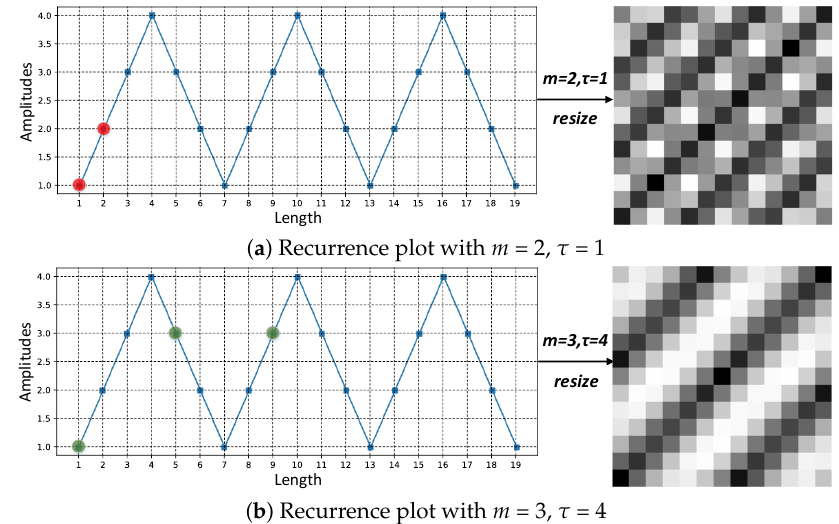
( b ) Recurrence plot with m = 3, τ = 4 Figure 4. The subsequences and RP images of a triangular periodic sequence, with different values of m and τ . The red and blue dots in ( a , b ) correspond to the first subsequences of the sequence when ( m , τ ) are ( 2,1 ) and ( 3,4 ) , respectively.